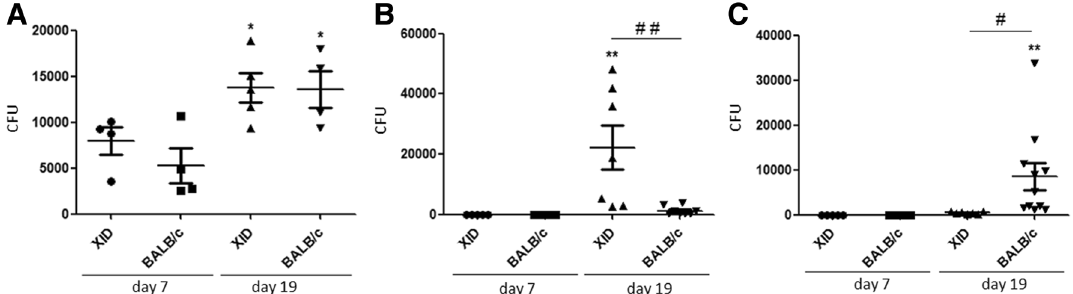
Figure 4. Analysis of fungal load in different target organs involved in cryptococcosis. ( A ) Analysis of the fungal load on days 7 and 19 of the bronchoalveolar lavage (BAL) of XID (n = 5) and BALB/c (n = 5) mice infected with C. gattii . ( B ) The brain of infected XID (n = 7) and BALB/c (n = 7) mice were also subjected to the counting of colony-forming units (CFU) at the same time. ( C ) Colony Forming Units (CFU) of the spleen were quantified under the same aspects (n = 11). Each symbol represents a value for an individual mouse, with the average indicated by the black line. The graphs show the results of 3 independent experiments. (*p < 0.05) for comparative degree between days 7 and 19 (7 d × 19 d), ( ## p < 0.01; # p < 0.05) for comparative degree between strains.